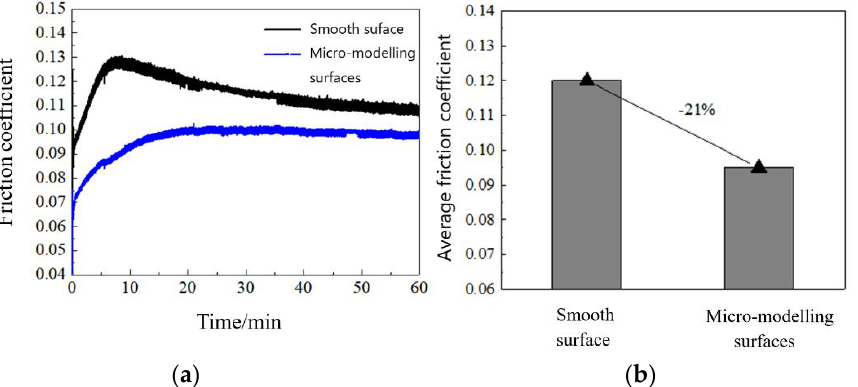
Figure 21. Friction coefficient of the surface of different specimens. ( a ) Friction Curve, ( b ) Average friction coefficient.